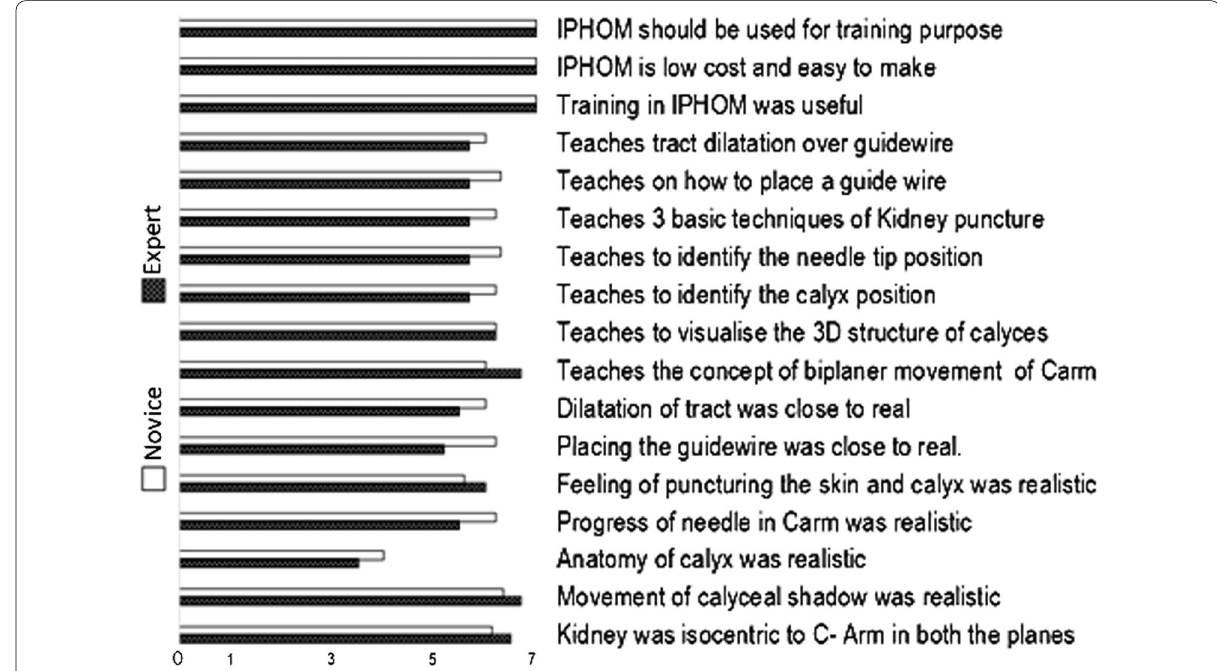
Fig. 5 Response in 7 point Likert scale to 17 feedback